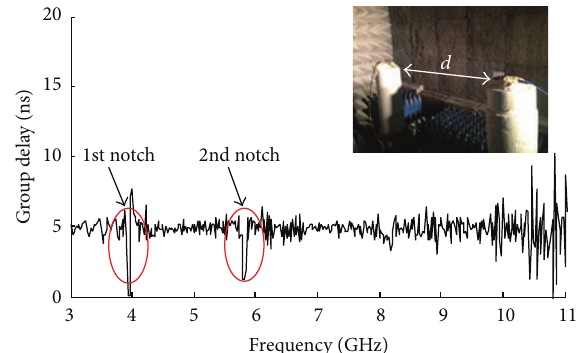
Figure 10: Measured group delay of the proposed